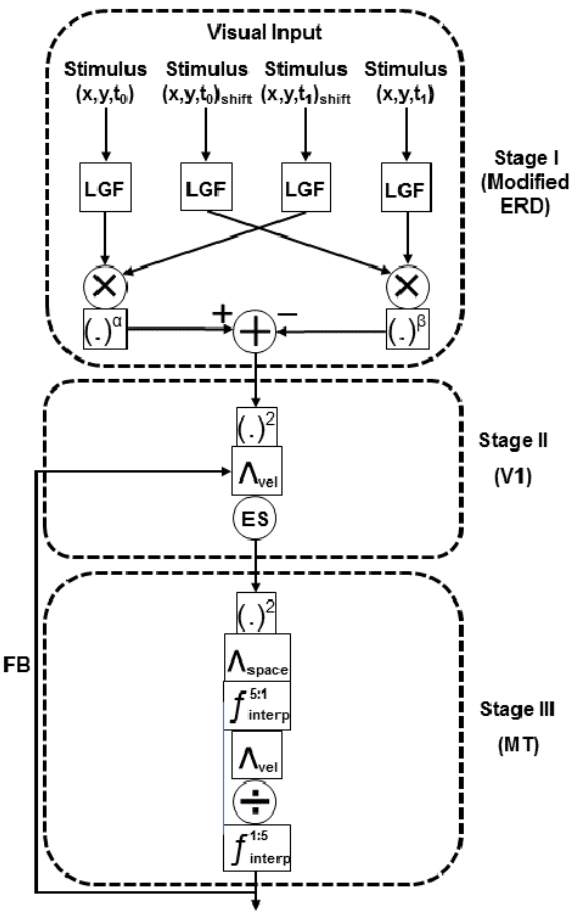
Figure 2: A model of a modified elaborated Reichardt detector (ERD) with end-stopped units (stage II) and a normalization (stage III). The model consists of a modified ERD where the input stimulus with and without a spatial shift (horizontal and vertical) and a tempo- rally delayed (time t 0 to t 1 ) are filtered by log-Gabor functions (LGF). The symbol × represents a multiplication operation of the filtered images. Then the exponentiation ( (.) α and (.) β ) of the correlation outputs are calculated before the subtraction step ( + represents summation with opposite signs). Stage II starts with a squaring op- eration followed by a velocity blur ( Λ vel ) realized by Gaussian filters for motion speeds and directions. After, a signal enhanced by FB (MT feedback) is calculated. End-stopped units (ES) are modelled round suppression response. Stage III starts with a squaring